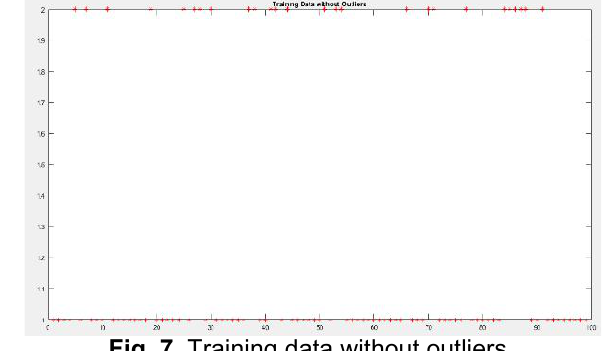
Fig. 7. Training data without outliers Fig. 7 represents training data set after the removal of outliers. Outlier removal is performed on the creatinine input of the fuzzy logic system